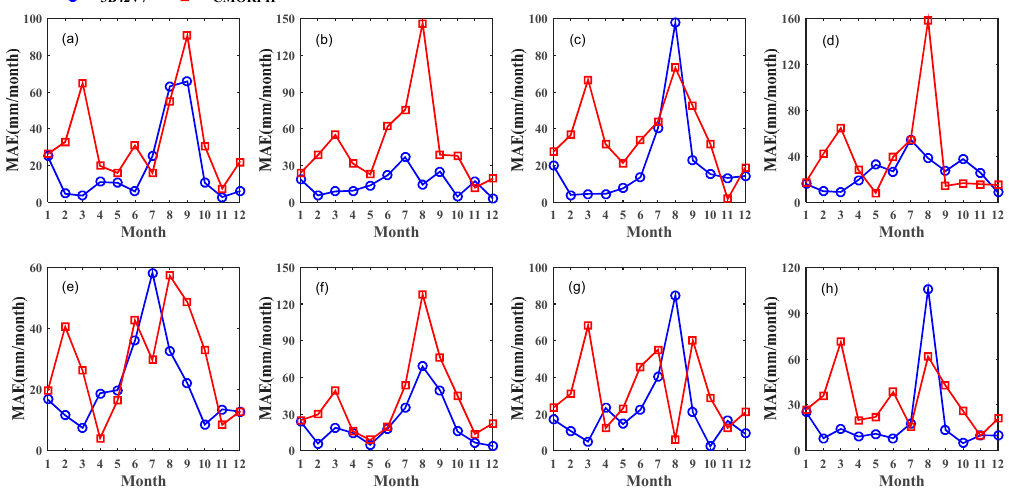
Figure 5. The variations of MAEs from 3B42V7 and CMORPH at the monthly scale (( a – h ) indicate that the gauge ID in Table 1).